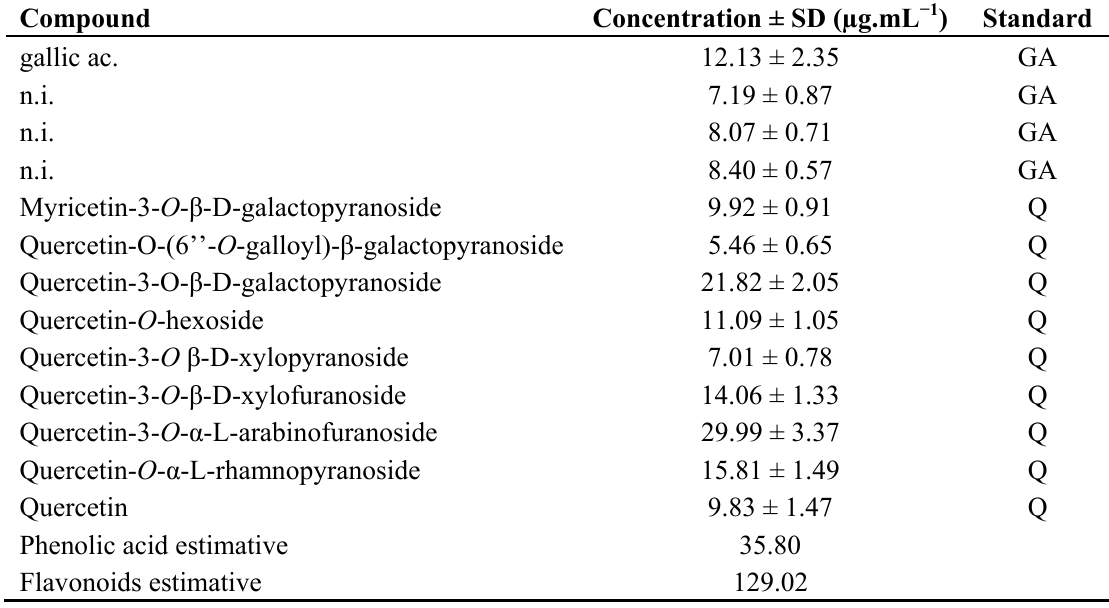
Table 3. Estimative of contents of phenolic acids and flavonoids glycosides derivatives in 70% EtOH leaves extract (n = 3) of M. bella expressed by the use of gallic acid and quercetin linear regression